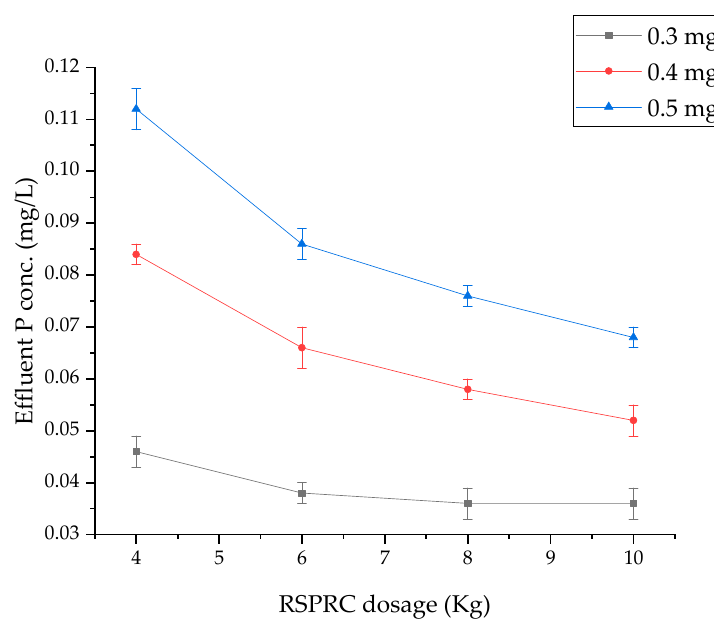
Figure 9. E ff ect of RSPRC dosage in the reactor on the e ffl uent phosphorus Figure 9. Effect of RSPRC dosage in the reactor on the effluent phosphorus concentration.